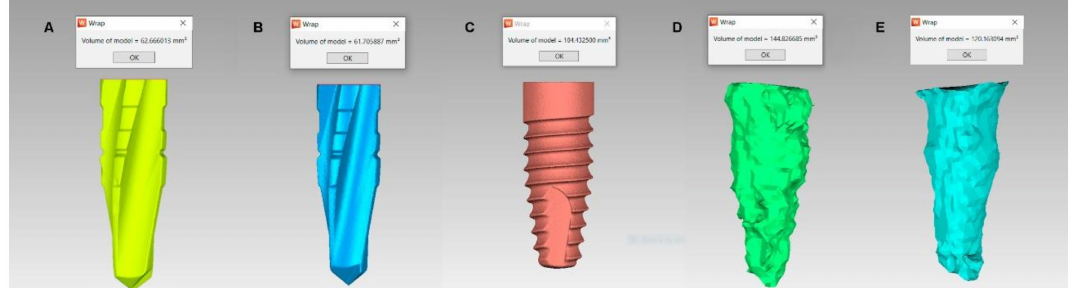
Figure 1. ( A ) Standard tessellation language (STL) digital files of the unused dental implant drills; ( B ) dental implant drills that were used 30 times; ( C ) dental implant; ( D ) first and ( E ) 30th osteotomy CBCT scan to a depth of 12